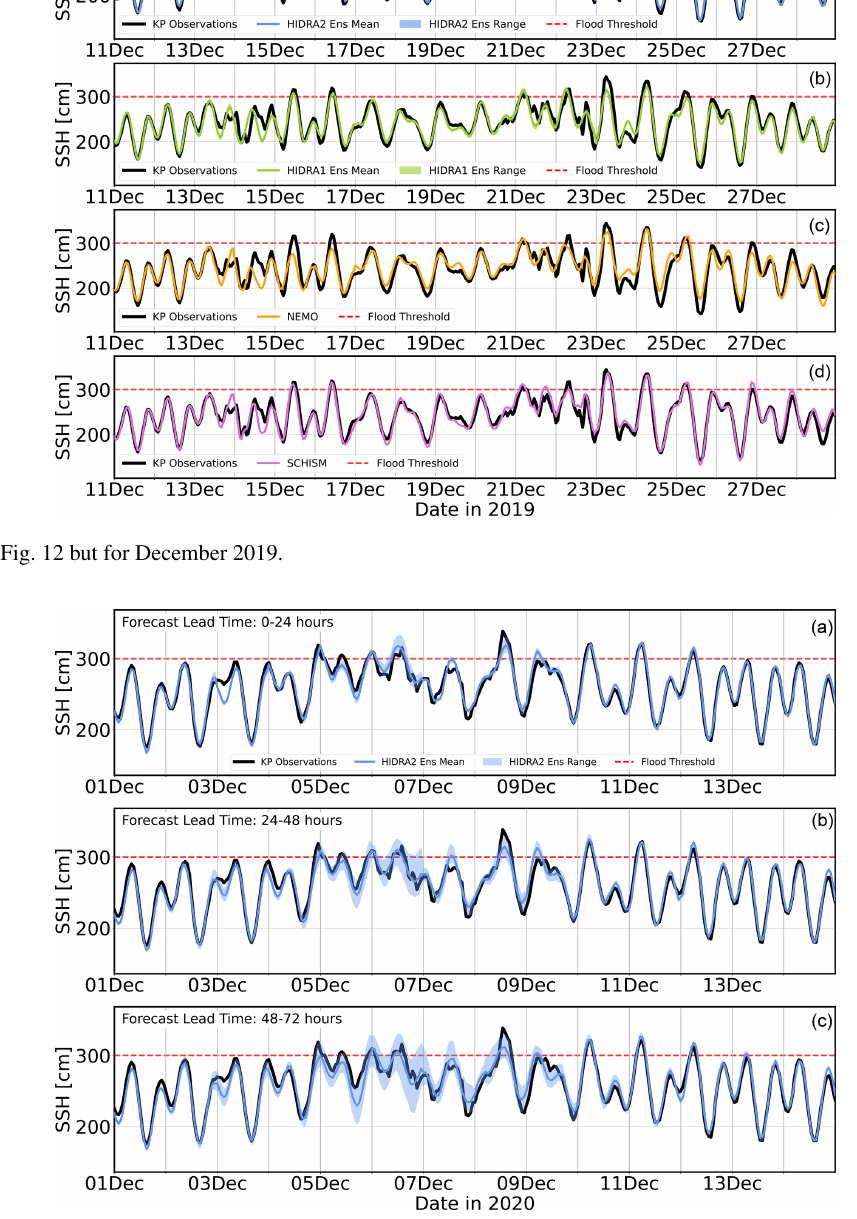
Figure 14. Comparison of the HIDRA2 ensemble spread on forecast days 1 (a) , 2 (b) and 3 (c) during December 2020 in Koper. Semi- transparent regions in the plots depict the minimum–maximum range of the HIDRA2